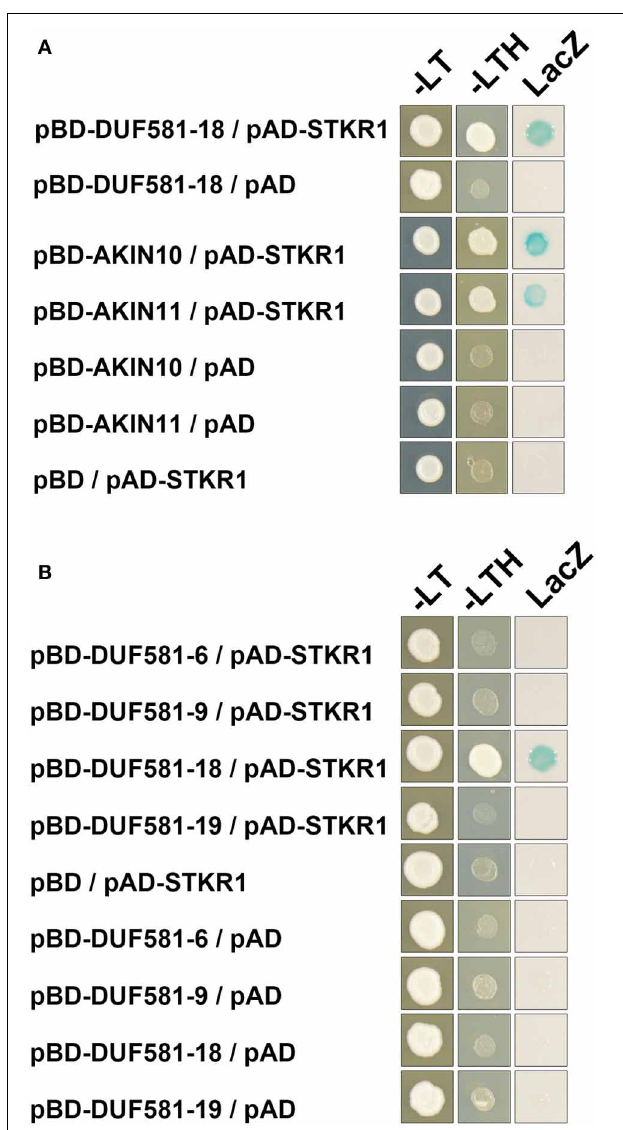
FIGURE 8 | AKIN10/11 and DUF581-18 share a common interaction partner. Yeast cells were grown on selective media for 3 days at 30 ◦ C before the pictures were taken. Empty BD and AD vectors served as control. –LT, yeast growth on medium without Leu and Trp. –HLT, yeast growth on medium lacking His, Leu, and Trp, indicating expression of the HIS3 reporter gene. LacZ, activity of the lacZ reporter gene. (A) AKIN10/11 or DUF581-18 fused to the GAL4 DNA-binding domain (BD) was expressed in combination with STOREKEEPER1 (STKR1) fused to the GAL4 activation domain (AD) in yeast strain Y190. (B) Different DUF581 proteins from Arabidopsis fused to the GAL4 DNA-binding domain (BD) were expressed in combination with STOREKEEPER1 (STKR1) fused to the GAL4 activation domain